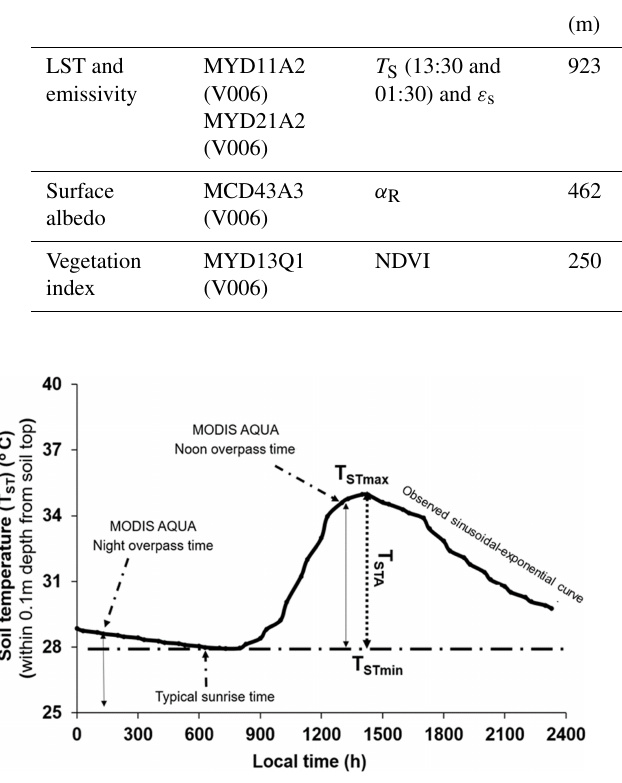
Figure 2. An illustrative example of the typical diurnal variation of observed soil temperature ( T ST ) (from the surface to 0.1m depth) at OzFlux sites and timings of MODIS AQUA observations. Here, T STmax and T STmin are maximum and minimum point-scale ob- served soil surface